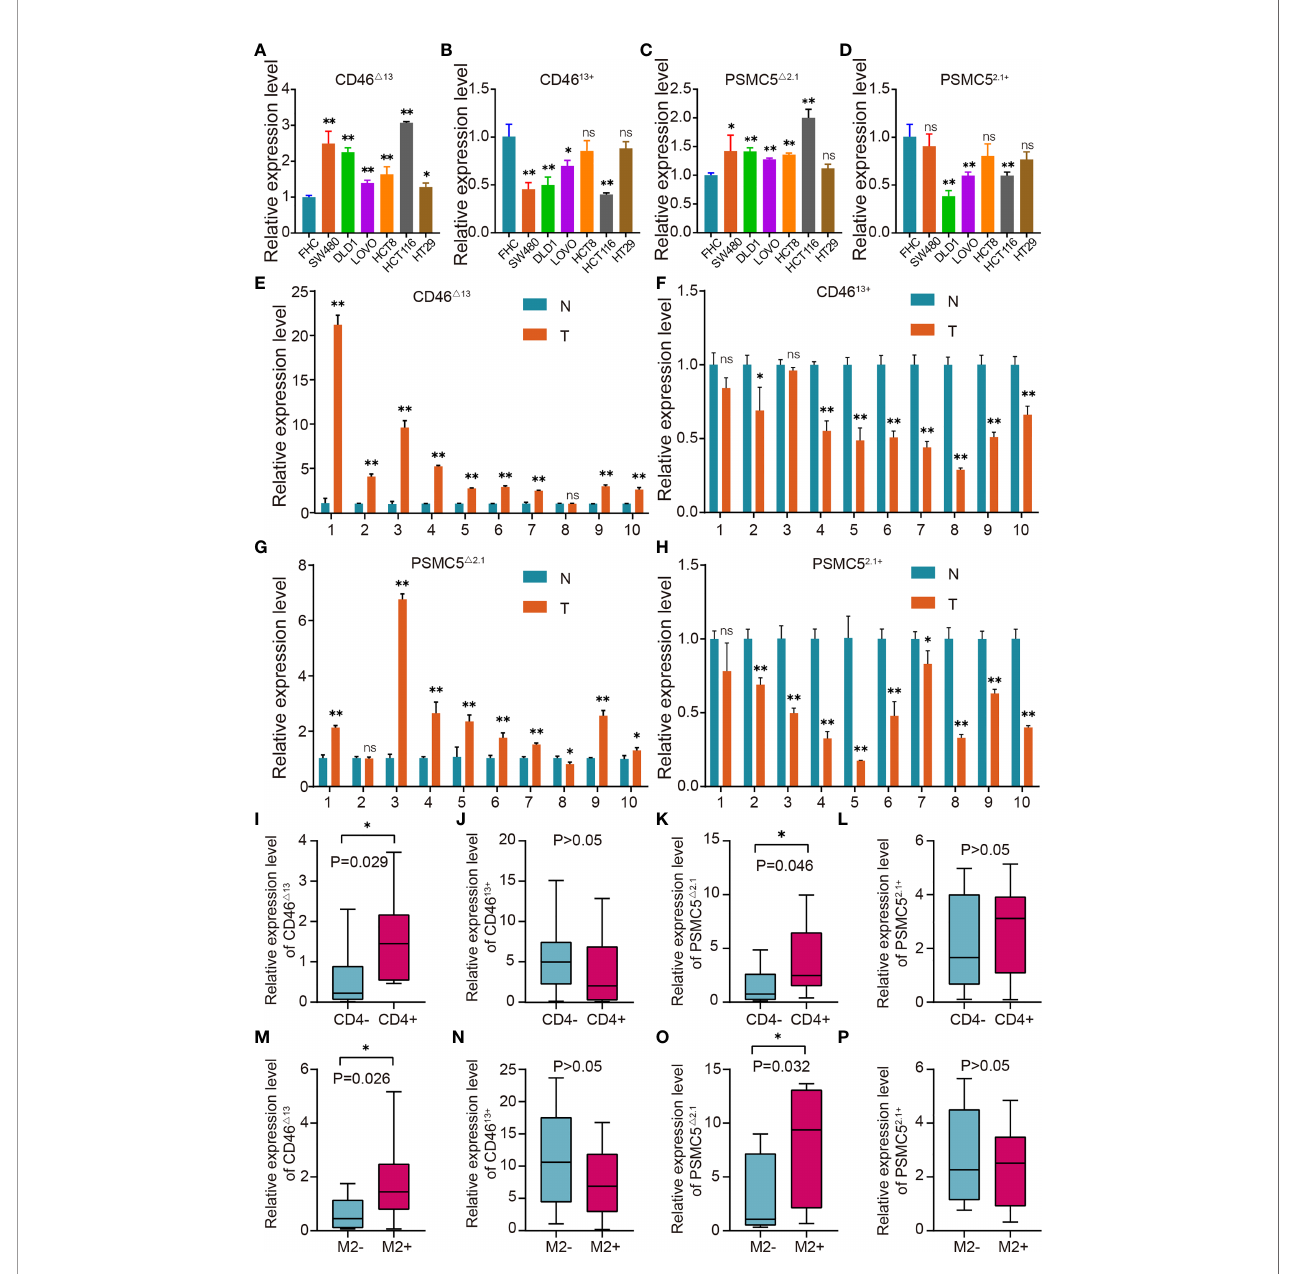
FIGURE 9 | OS-ASE levels and the association between OS-ASEs and in fi ltration of immune cells in colon cancer. (A – D) The expression levels of CD46 △ 13 and CD46 13+ , PSMC5 △ 2.1 and PSMC5 2.1+ in colon cancer cell lines (HCT116, HCT8, DLD1, LoVo, SW480, SW620) and FHC cell lines. (E – H) Expression analysis of CD46 △ 13 , CD46 13+ , PSMC5 △ 2.1 and PSMC5 2.1+ in 10 pairs of colon cancer tissue samples. (I – L) The expression of CD46 △ 13 , CD46 13+ , PSMC5 △ 2.1 and PSMC5 2.1+ in colon cancer samples characterized by CD4+/CD4- T cell in fi ltration. (M – P) The expression of CD46 △ 13 , CD46 13+ , PSMC5 △ 2.1 and PSMC5 2.1+ in colon cancer samples characterized by high/low in fi ltration of M2 macrophages. ns p > 0.05, *p < 0.05 and **p <